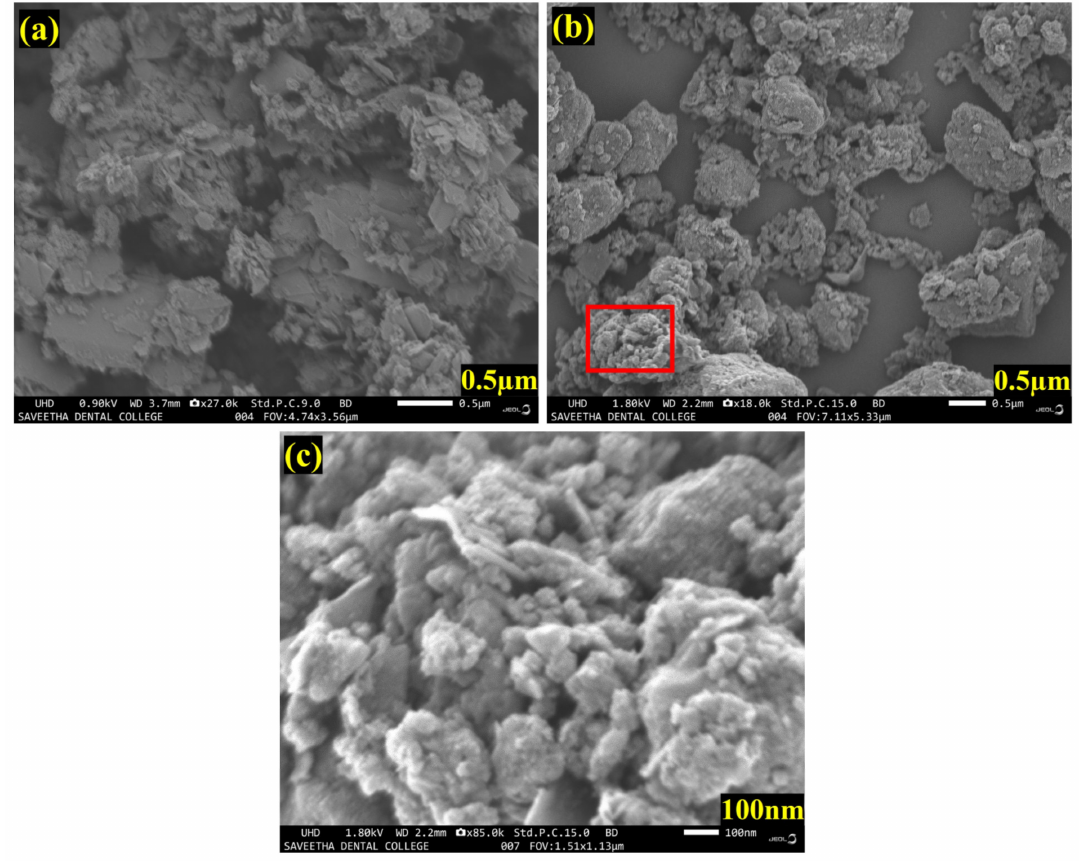
Figure 4. FE-SEM images of ( a ) stacked layer of MXene sheets, ( b ) MXene/PHC composite and ( c ) enlarged image of ( b ), as highlighted in the red